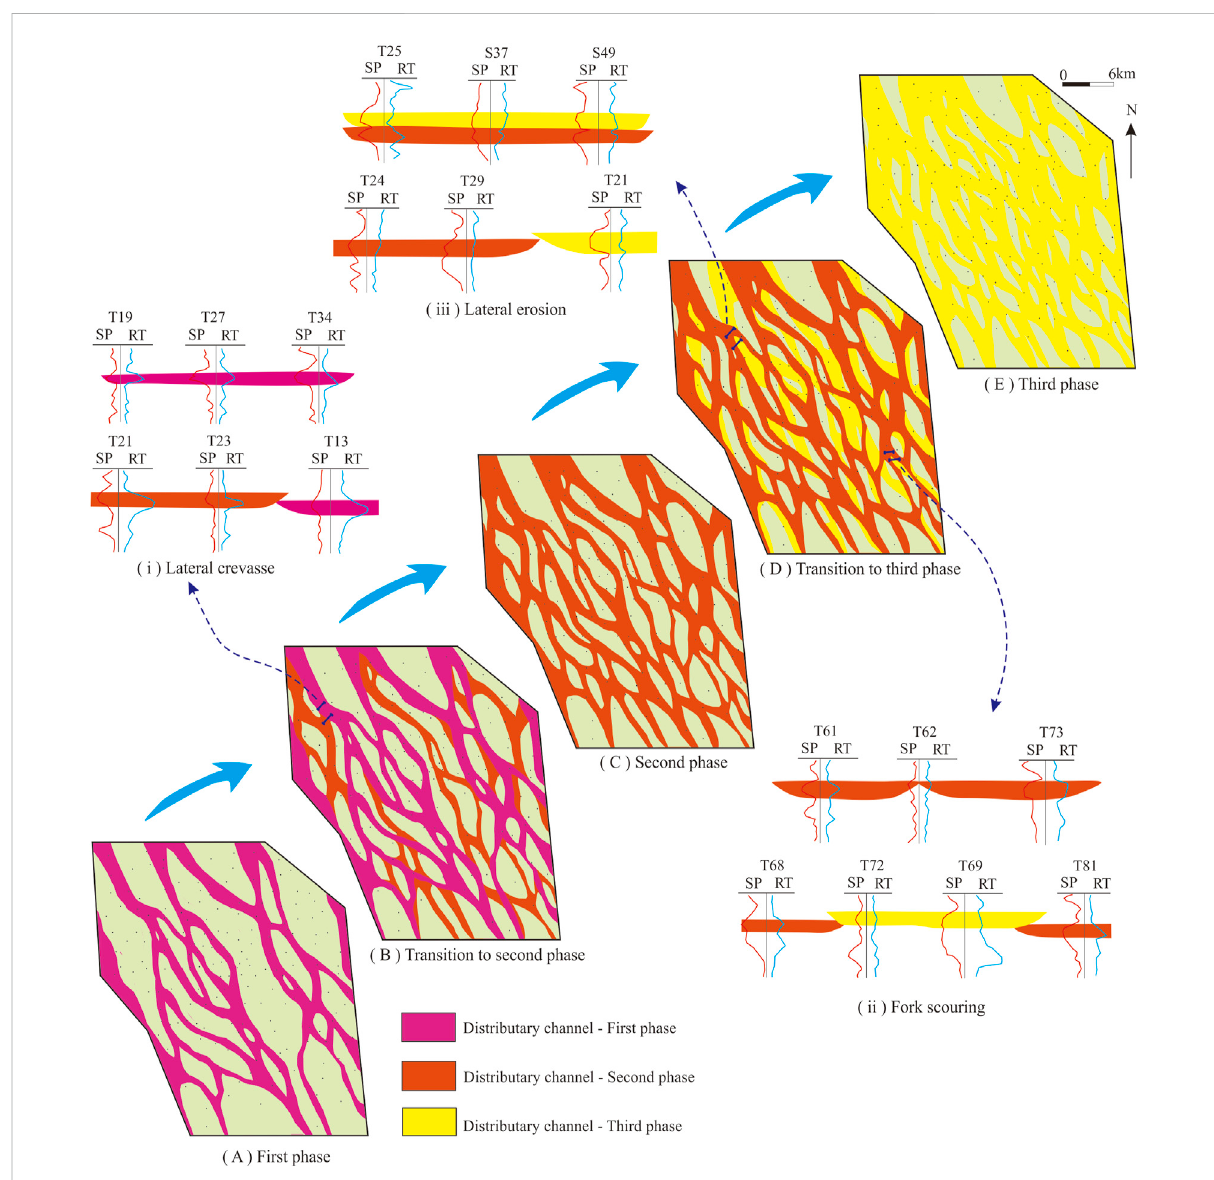
FIGURE 9 Evolution of distributary channels and single sand body architecture and genesis mechanisms in the LH-8 member. (i, ii, iii) are the three single sand body architecture models, (A,C,E) are the three phase distributary channels, and (B,D) are the transitional phases.